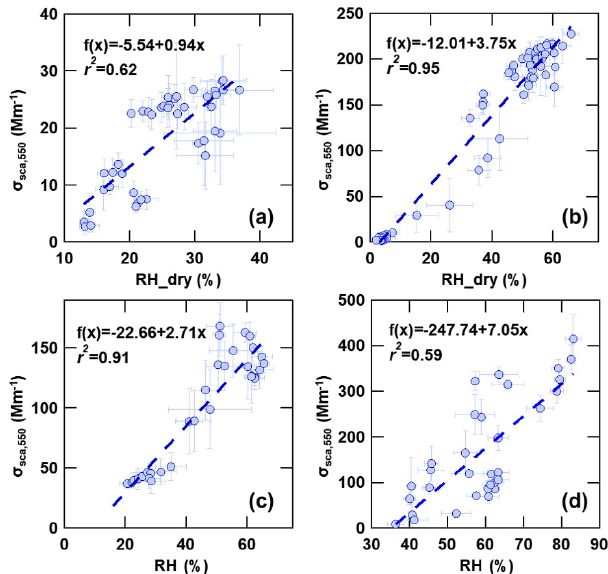
Figure 8. σ sca at 500nm as a function of relative humidity (RH, in %) for those cases when the PBL was (a) clean and dry, (b) polluted in the lower PBL and dry, (c) polluted in the upper PBL in the flight on 2 June, and (d) polluted in multiple layers of the PBL in the flight on 6 June. The linear regression best-fit lines through the data are shown (dashed lines). The regression relationships and coefficients of determination are given in each